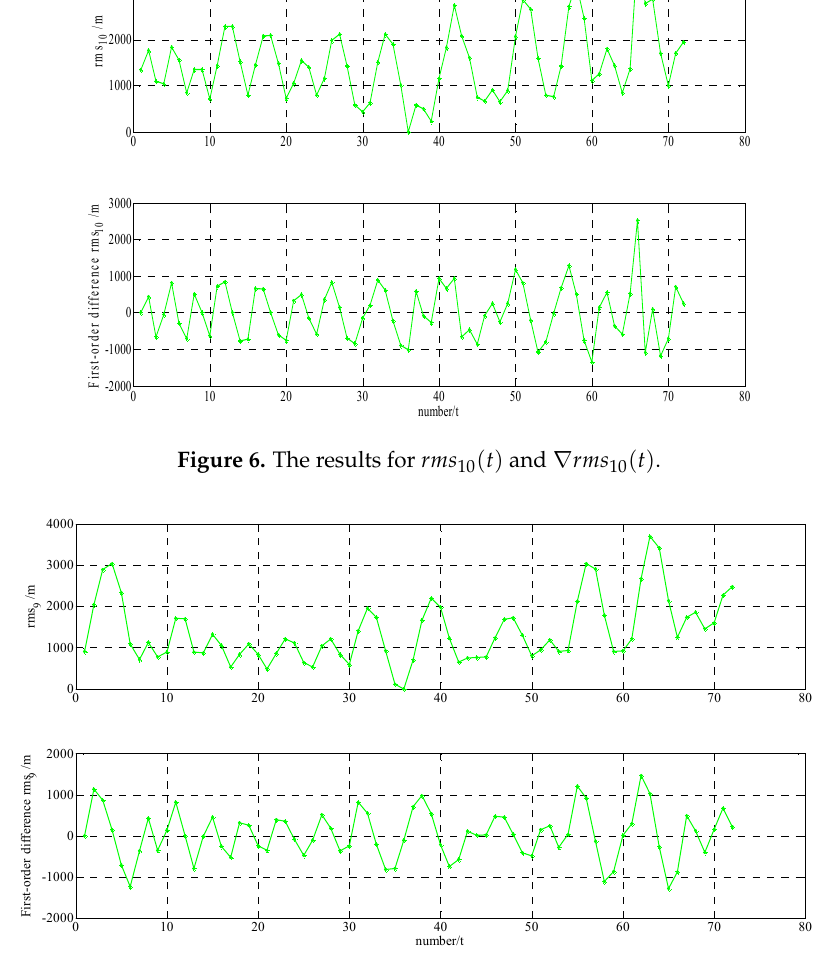
Figure 7. The results for